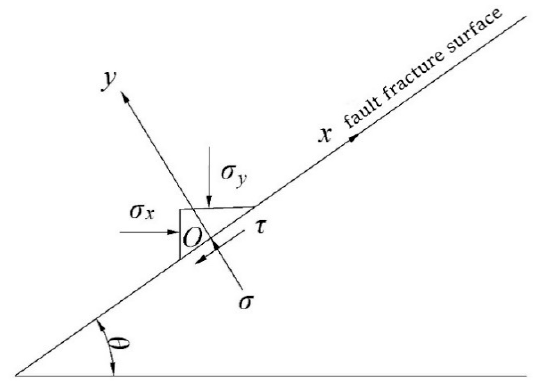
Figure 1. Mechanical model of fault plane slip.